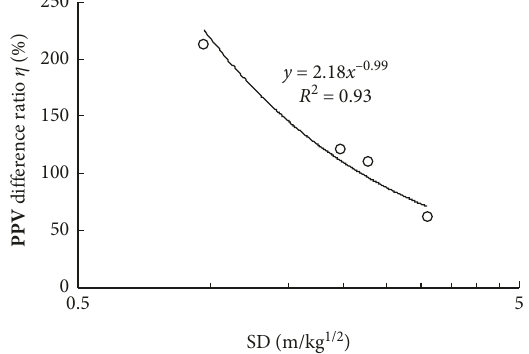
Figure 28: PPV difference ratio of blastholes S1 and S2 in the production blasting